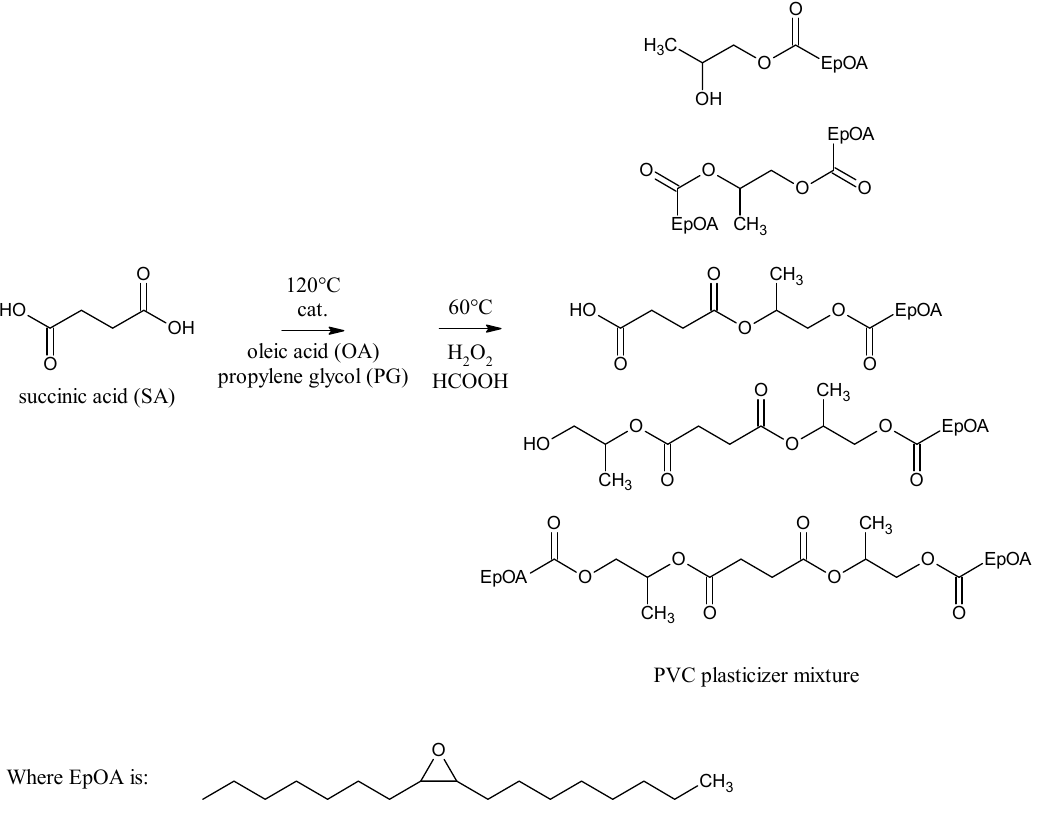
Figure 1. The chemical structure of the main compounds of the proposed mixture of epoxidized esters of succinic acid, propylene glycol, and oleic acid as a PVC plasticizer. For the obtained plasticizer samples, GC, FT–IR, and TGA analyses were performed and the physicochemical properties were determined. The main goal of the work